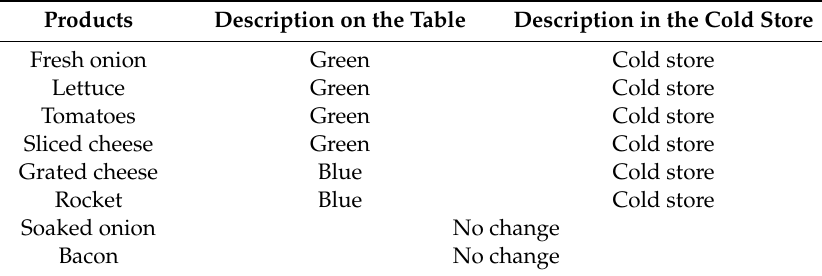
Table 5. Changes introduced in the